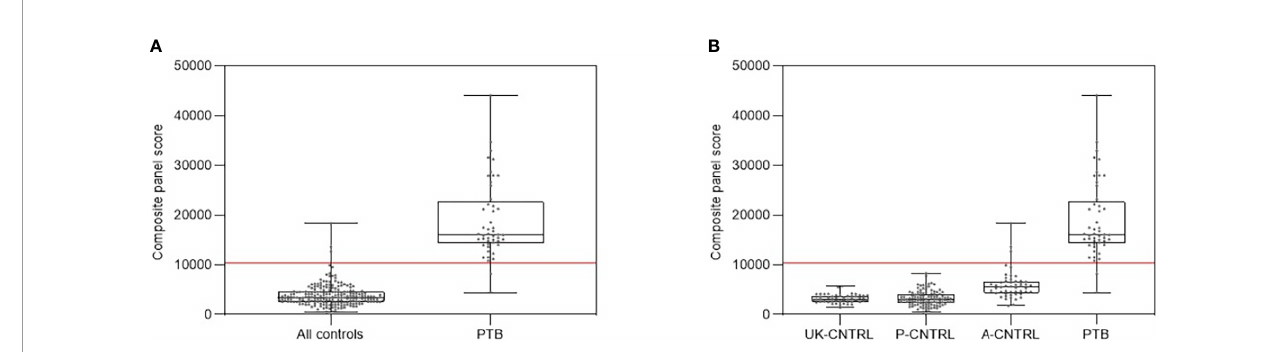
FIGURE 6 | (A) Combined box and scatter plot graphical depictions of composite panel score of the simple 3-plex biomarker panel between all controls and PTB, displaying the cut-off value y= 10389 for discrimination of PTB from all controls with 95.9% sensitivity and 98.6% speci fi city. (B) Combined box and scatter plot graphical depictions of expression of the simple 3-plex biomarker panel between individual control and PTB displaying the cut-off value y= 10389 for discrimination of PTB from all controls with 95.9% sensitivity and 98.6% speci